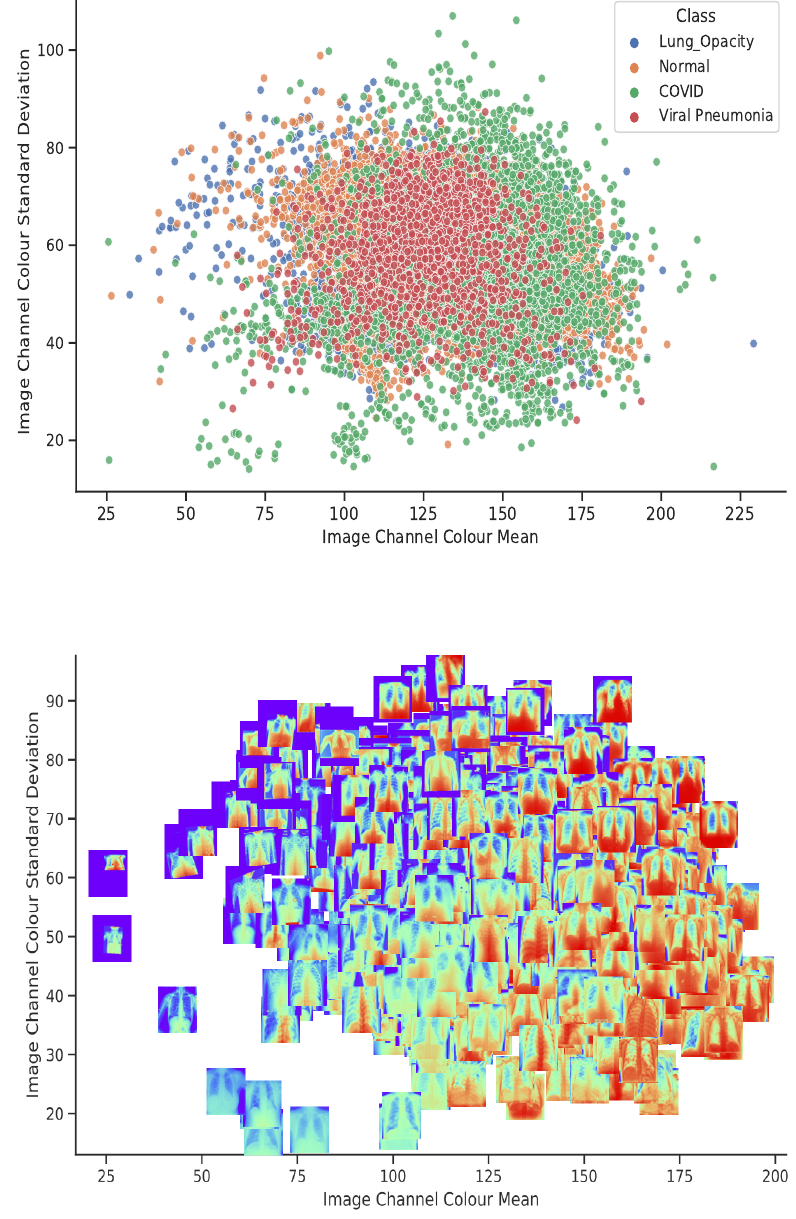
Figure 7. A side-by-side comparison of the dataset clusters using image mean and standard deviation (top-panel) and the 10% (bottom-panel) zoom at the centre of centre mean of the images.